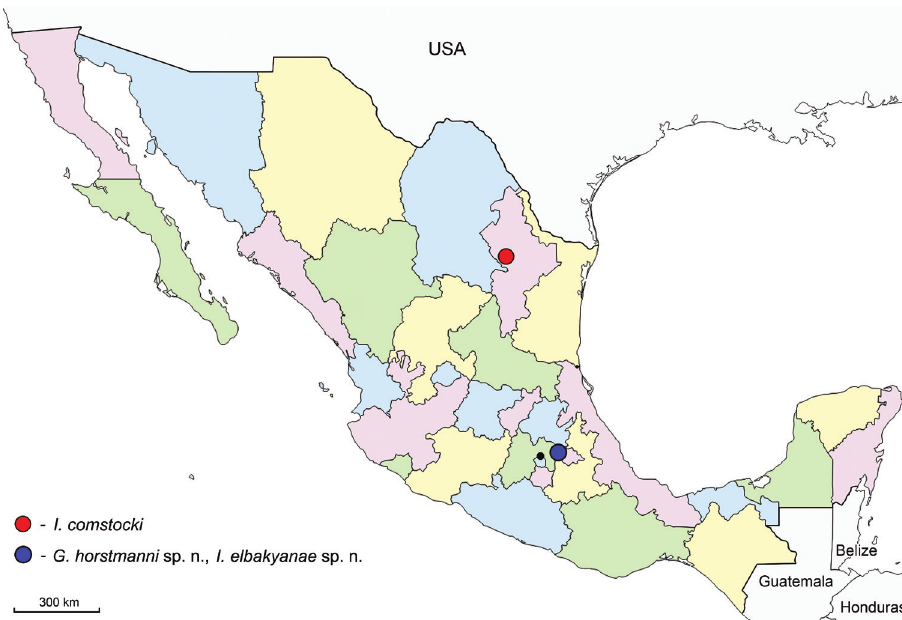
Figure 12. Distribution map of Gelanes and Idiogramma species in